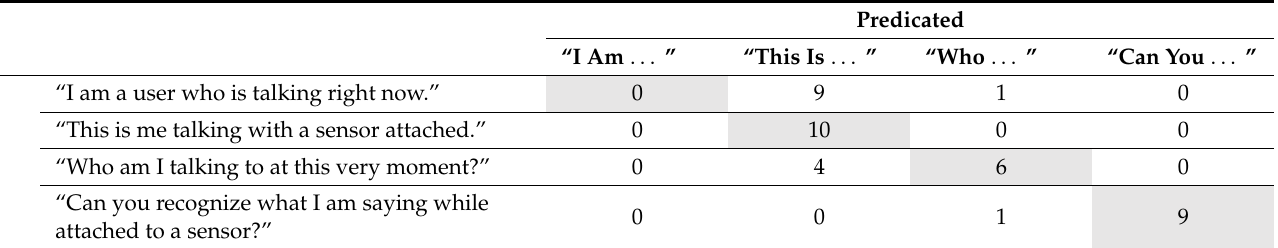
Table 7. Four-class confusion matrix for spoken sentences. Rows represent actual class and columns represent predicted class. Predicated “I Am . . . ” “This Is . . . ”